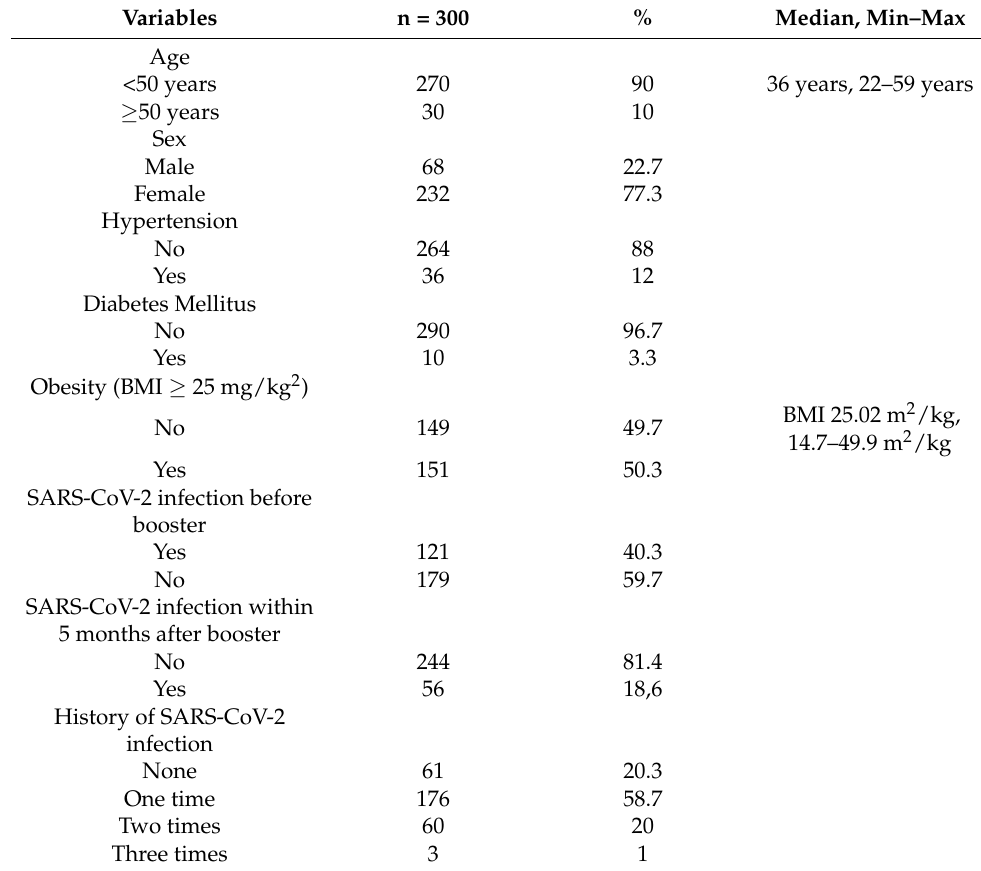
Table 1. Characteristics of research